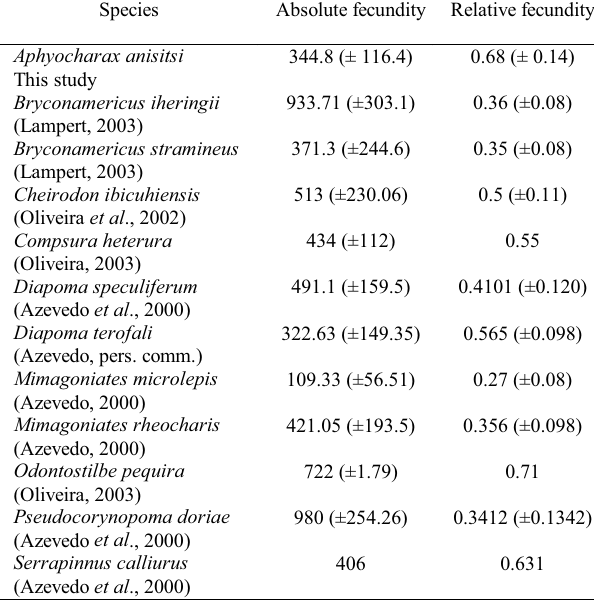
Table 2. Absolute and relative mean fecundity values (± Stan- dard Deviation) of small size characids. Relative fecundity values = Number of oocytes / mg of total body